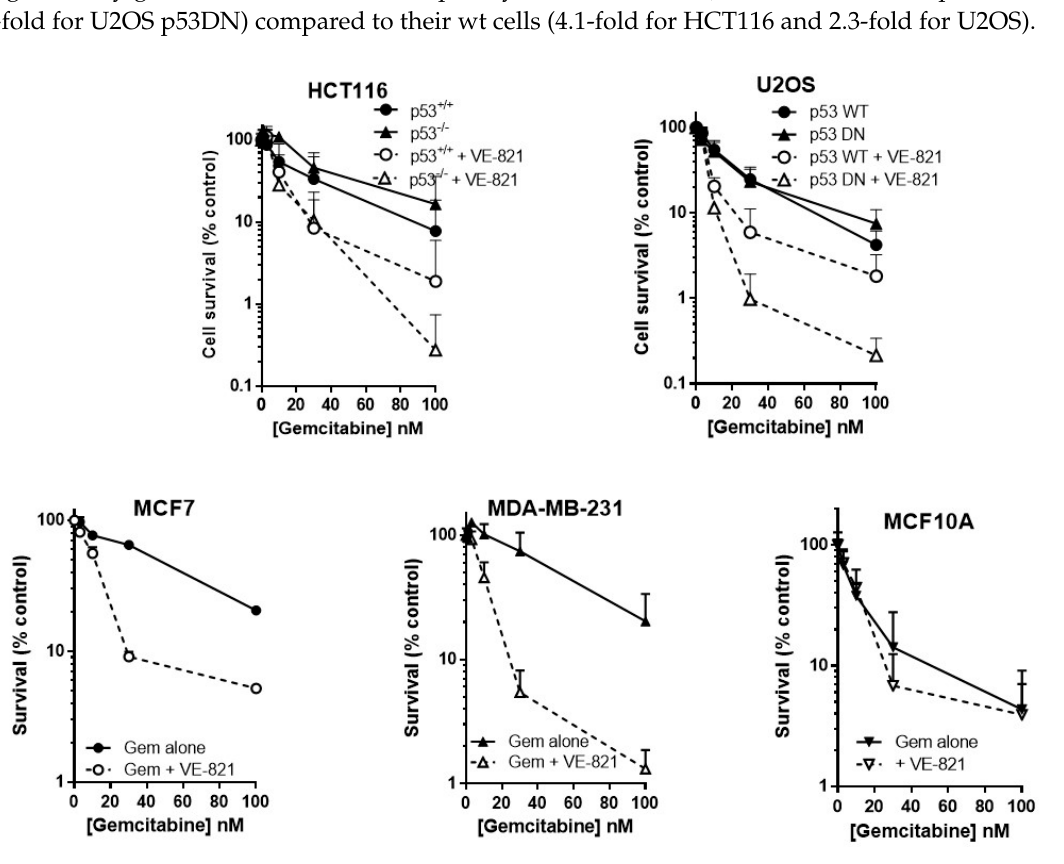
Figure 2. VE821 potentiates gemcitabine, irrespective of p53 status, but not nontumourigenic immortalised breast cells. Cells were seeded into 6-well plates and allowed to adhere for 24 h. Following 24 h co-exposure to gemcitabine alone (filled circles, solid line) or gemcitabine + 1 µ M VE-821 (open circles, dashed line) cells were counted and reseeded at low density for colony formation. Colonies were allowed to grow for 2 weeks before being fixed, stained, and counted. Data are the mean + SEM of 3 individual experiments.